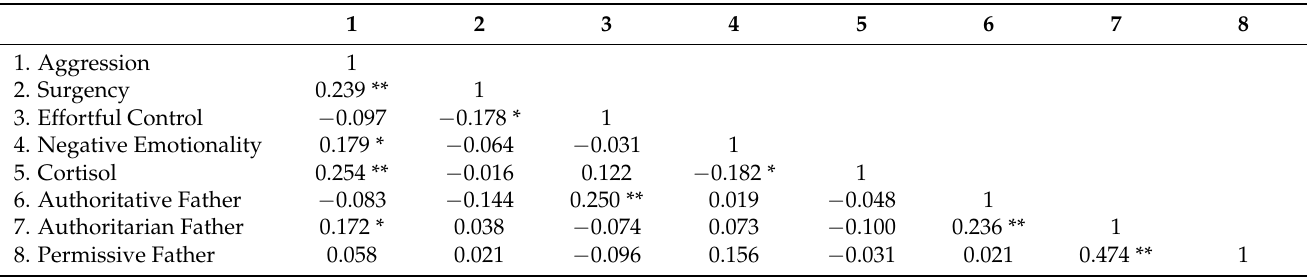
Table 2. Correlations between study